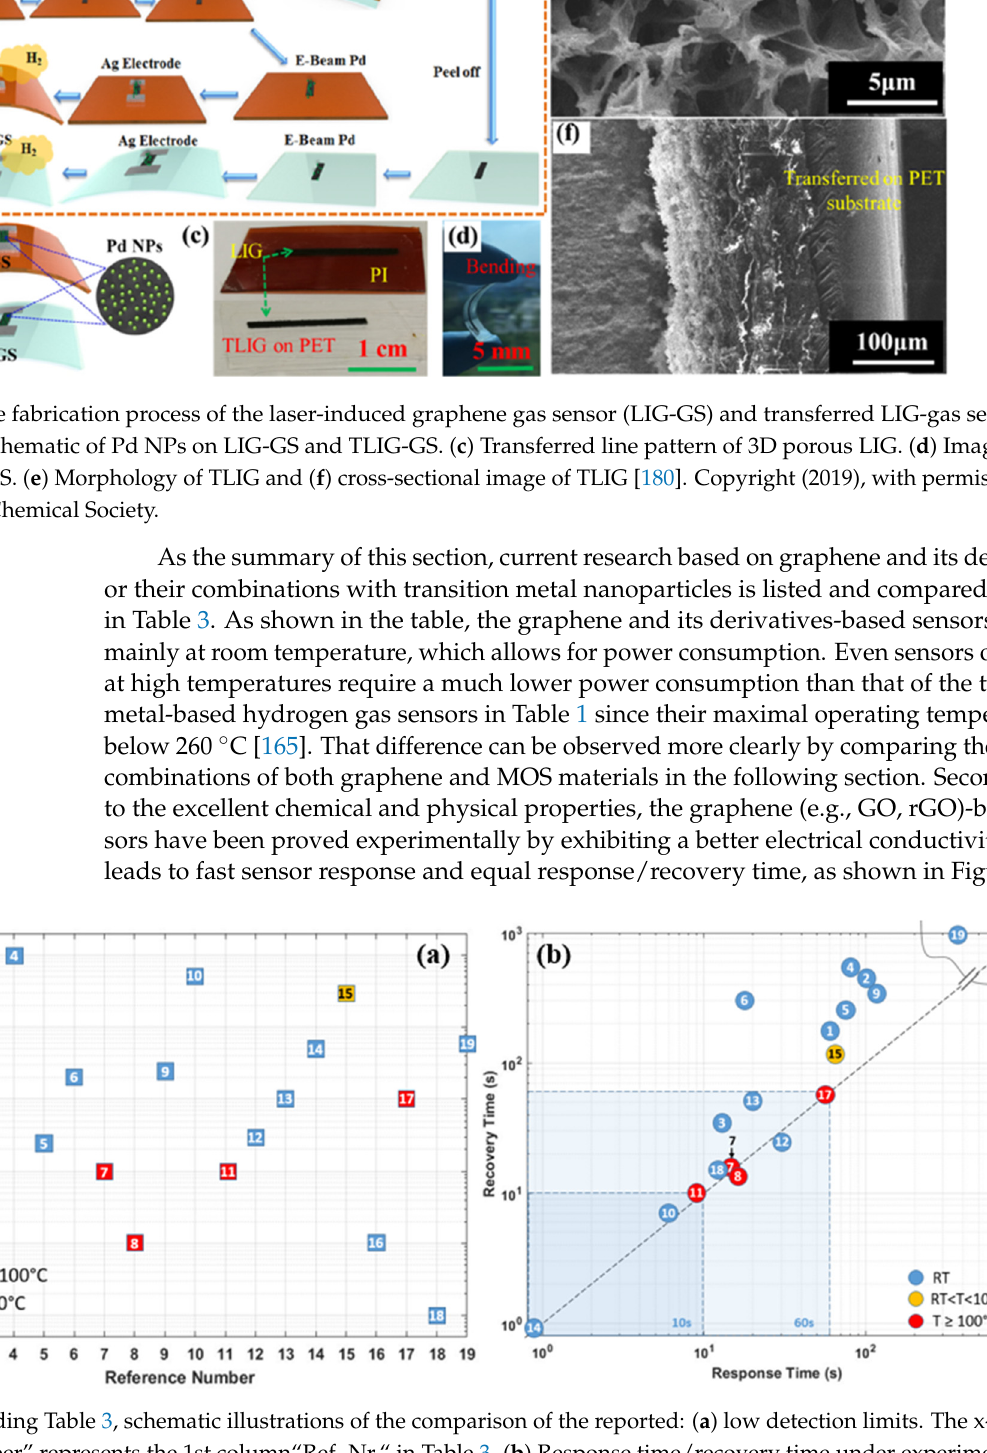
Figure 43. Regarding Table 3, schematic illustrations of the comparison of the reported: ( a ) low detection limits. The x-axis “Reference Number” represents the 1 st column“Ref. Nr.“ in Table 3. ( b ) Response time/recovery time under experimental conditions in